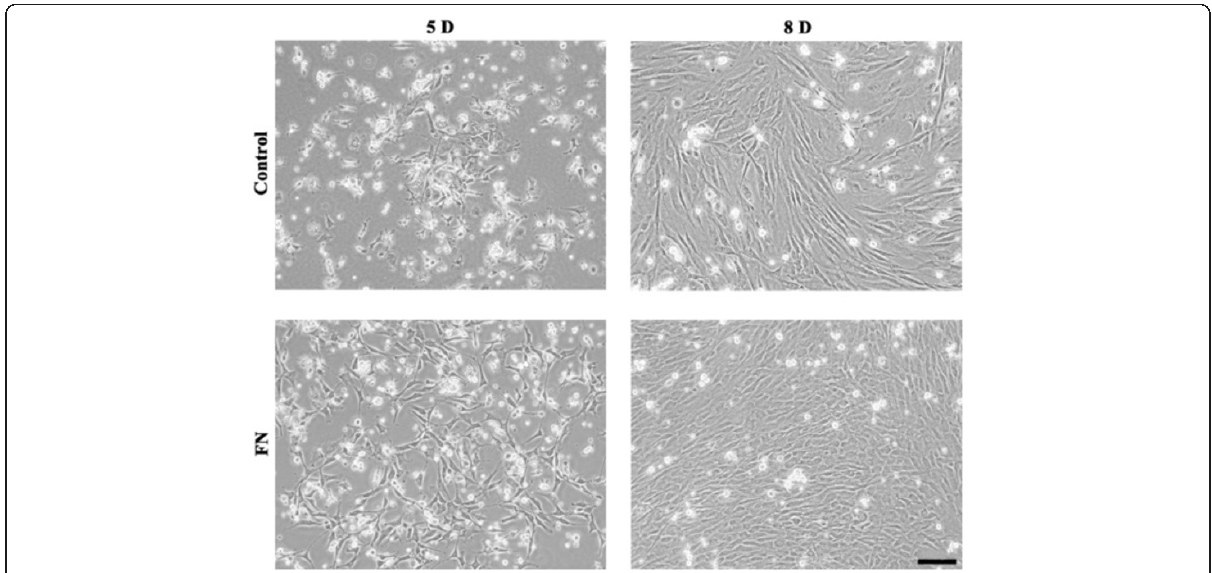
Figure 3 Effects of culture dish surface coating on EPCs in cultures. Unselected mononuclear cells were seeded in EGM-2 medium without serum supplementation on FN coated culture dishes. Morphology of EPCs was respectively observed on day 5 and day 8 after culturing. In the control group, cells were seeded on culture dishes without coating. Cells seeded on FN coated dishes had better adherence than cells seeded on dishes without coating 5 days after culturing, which remained observable until 8 days after culturing. Bar =100 μ